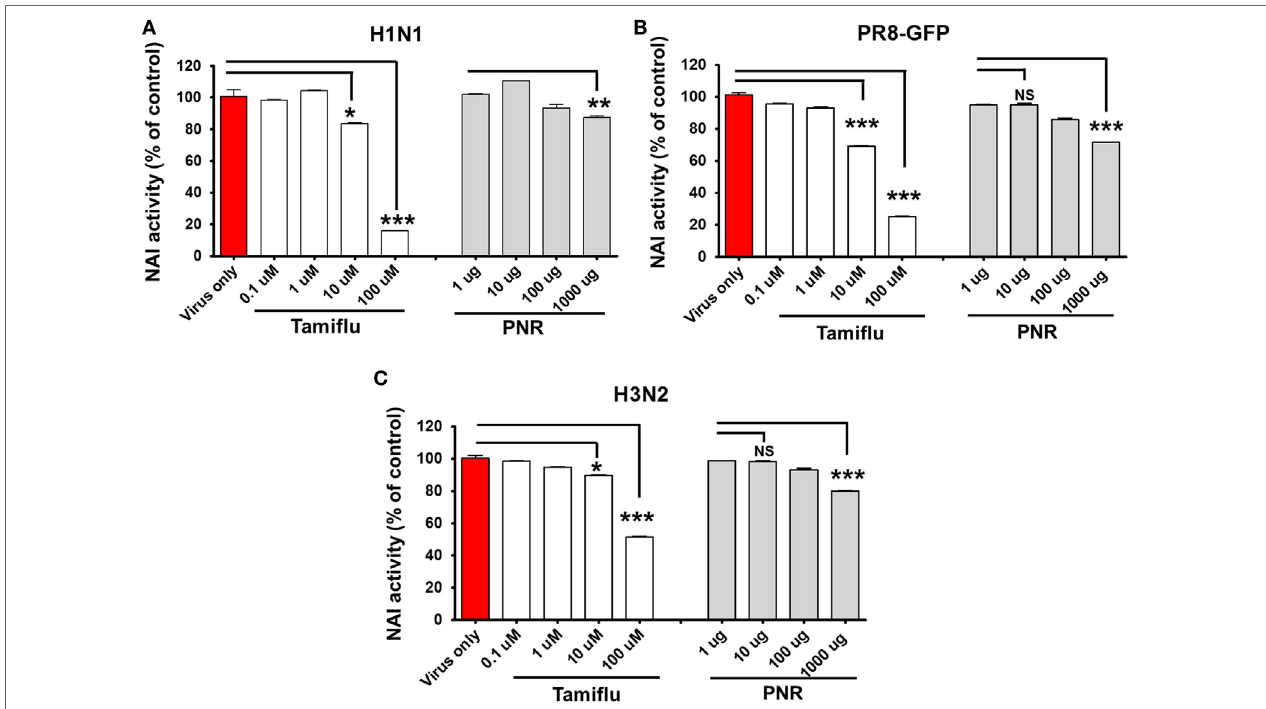
FigUre 7 | Measurement of the antiviral activity of Panax notoginseng root (PNR) using neuraminidase inhibition assays. Influenza A viruses (A/PR/8/34-GFP H1N1, and H3N2) were added at 32 hemagglutination units (HAUs) to the indicated concentrations of PNR, oseltamivir phosphate (positive control), or phosphate-buffered saline (PBS) (negative control), mixed with NA-Fluor ™ substrate, and incubated at 37°C for 1 h in the dark (a–c) . Fluorescence was monitored via fluorescence spectrometry (excitation, 365 nm; emission, 445 nm). Data are presented as the mean ± SEM of three independent experiments. Bar graph (mean ± SEM) statistics were determined using two-way ANOVA with Bonferroni’s correction (posttest), *** P < 0.001; ** P < 0.01; * P < 0.05. n.s., not